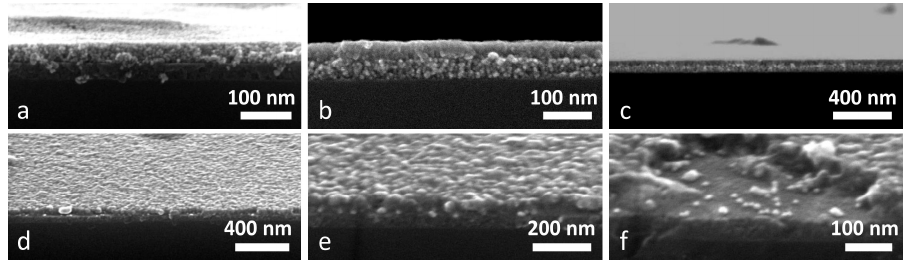
Figure 4. ( a – c ) SEM images of Au NPs layers embedded between TiO 2 and NiOfilms: TiO 2 is the bottom layer in ( a ) and the top layer in ( b , c ); ( d – f ) SEM images of Au NPs layers embedded between TiO 2 (bottom) and ZnO (top) at different magnifications. Brighter spots correspond to Au NPs.